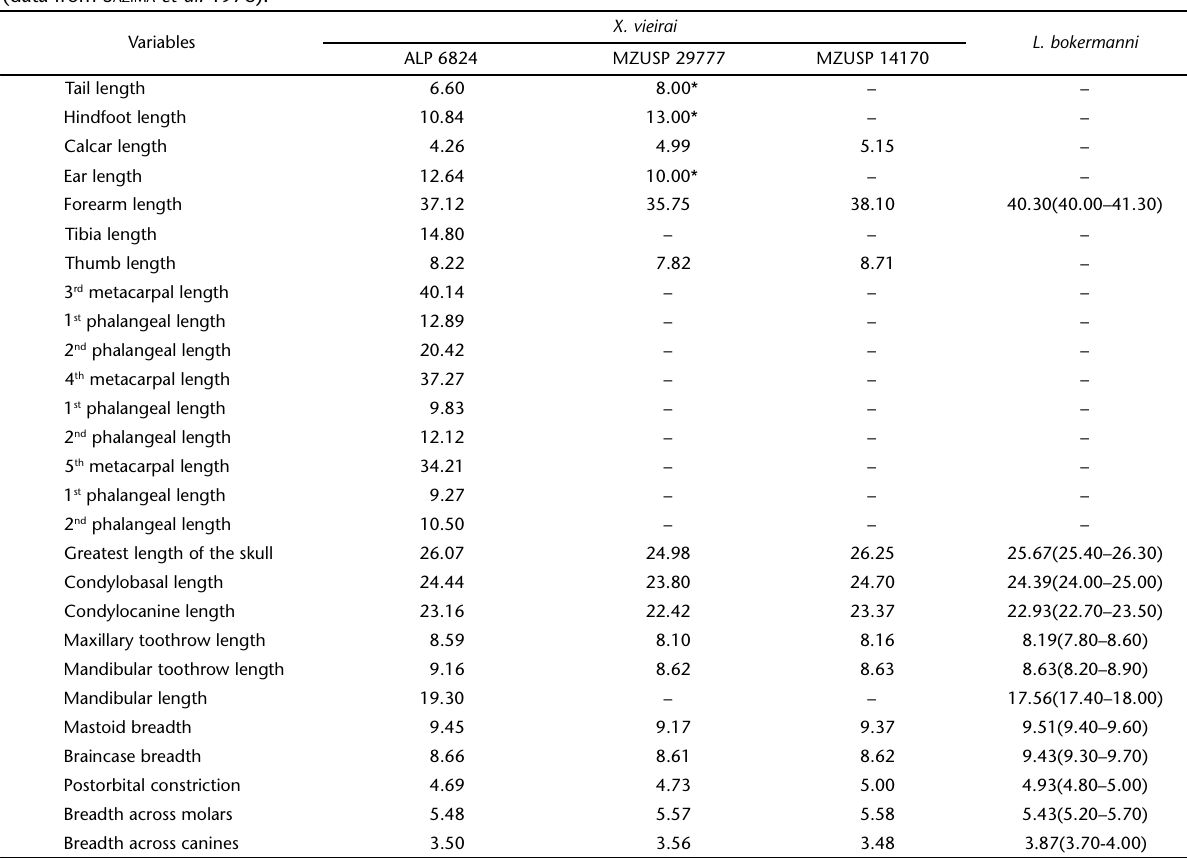
Table I. External and cranial measurements (in mm) of females of Xeronycteris vieirai from southeastern (ALP 6824) and northeastern Brazil (MZUSP 29777, holotype; MZUSP 14170, paratype), and females of Lonchophylla bokermanni from the type locality in southeastern Brazil (data from S AZIMA et al.